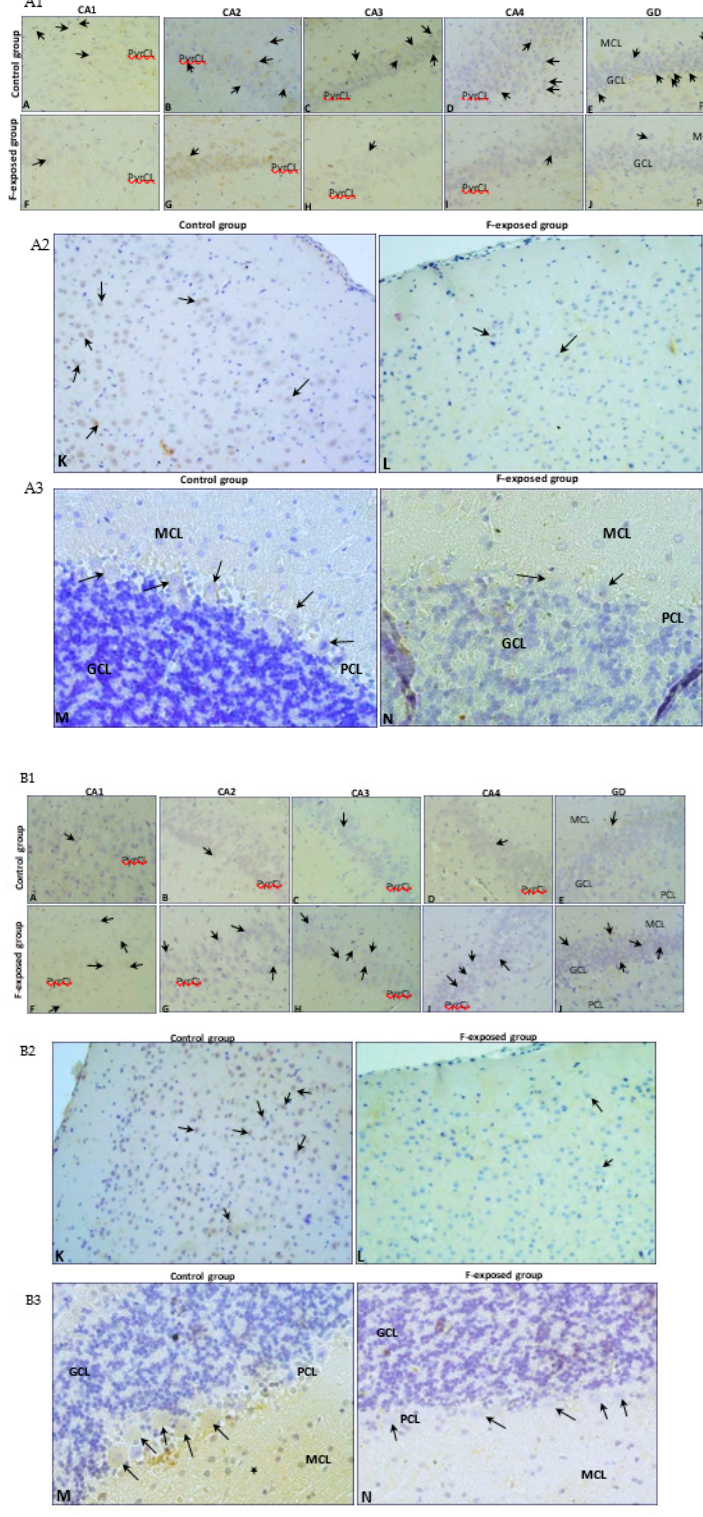
Figure 5. Immunolocalization of TIMP2 ( A1 – A3 ) and TIMP9 ( B1 – B3 ) in analyzed brain structures (hippocampus, objective magnification × 40 ( A1 , B1 ); prefrontal cortex, objective magnification × 20 ( A2 , B2 ); cerebellum, objective magnification × 20 ( A3 , B3 )). Hippocampus (CA1–CA4): area of cornu ammonis (CA); gyrus dentate (GD); pyramidal cell layer (PyrCL); granular cell layer (GCL); polymorphic cell layer (PCL); molecular cell layer